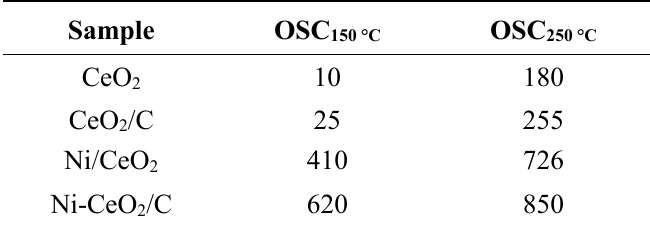
Table 2. OSC in μmol CO 2 /g sample for the studied samples at different